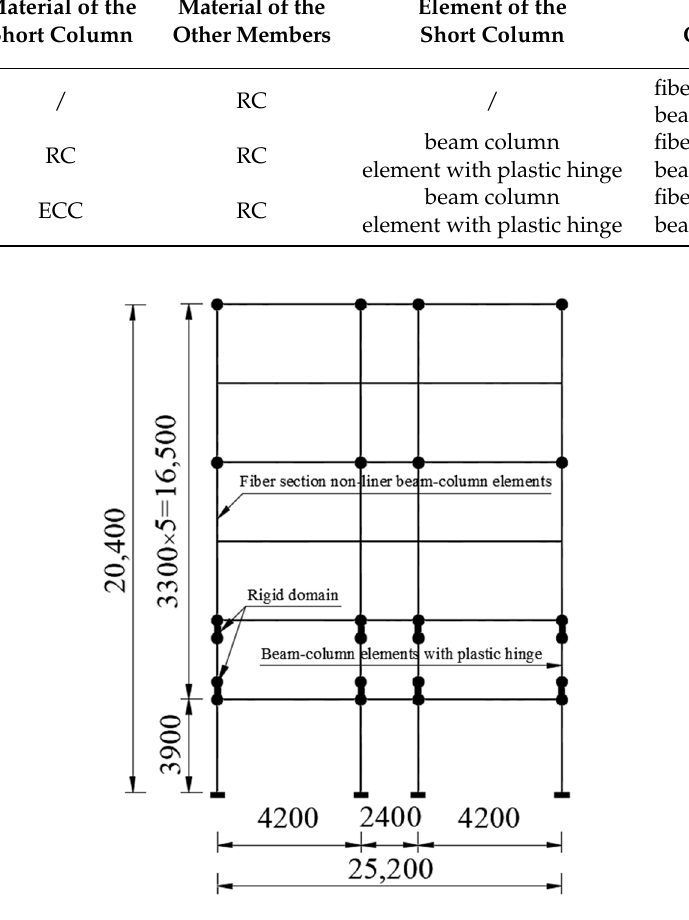
Figure 3. Finite element model of the analytical frames (unit: